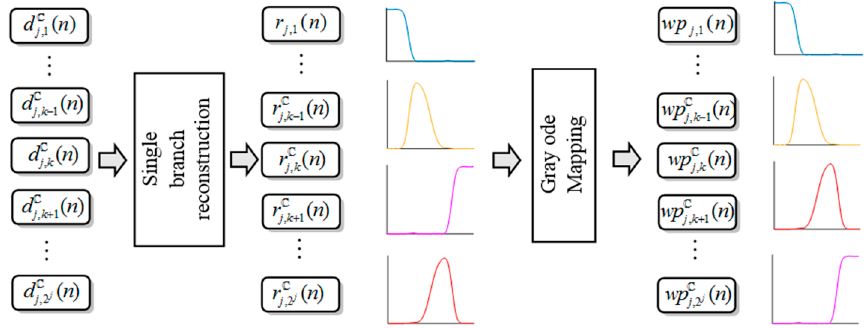
Figure 7. Rearrangement of the orders of dyadic wavelet packets.